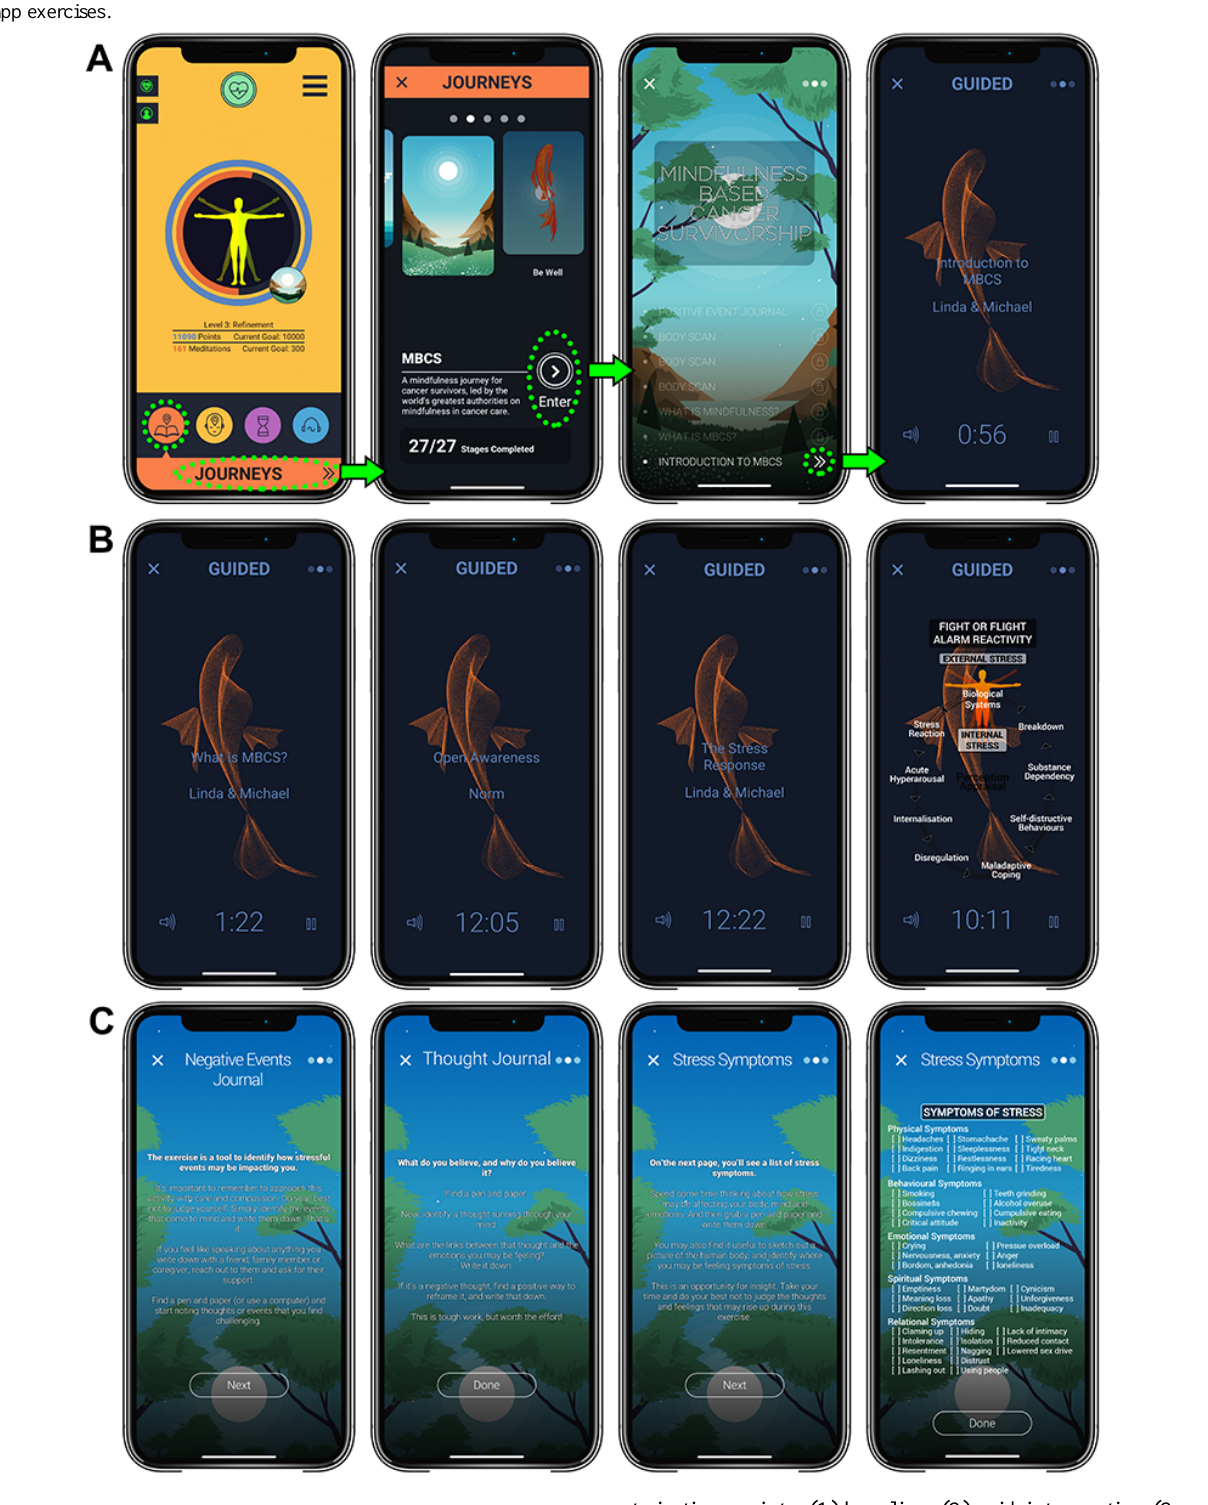
Figure 1. The Mindfulness Based Cancer Survivorship (MBCS) Journey Contained within Am . (A) Navigation menu. (B) Core audio content (C) In-app